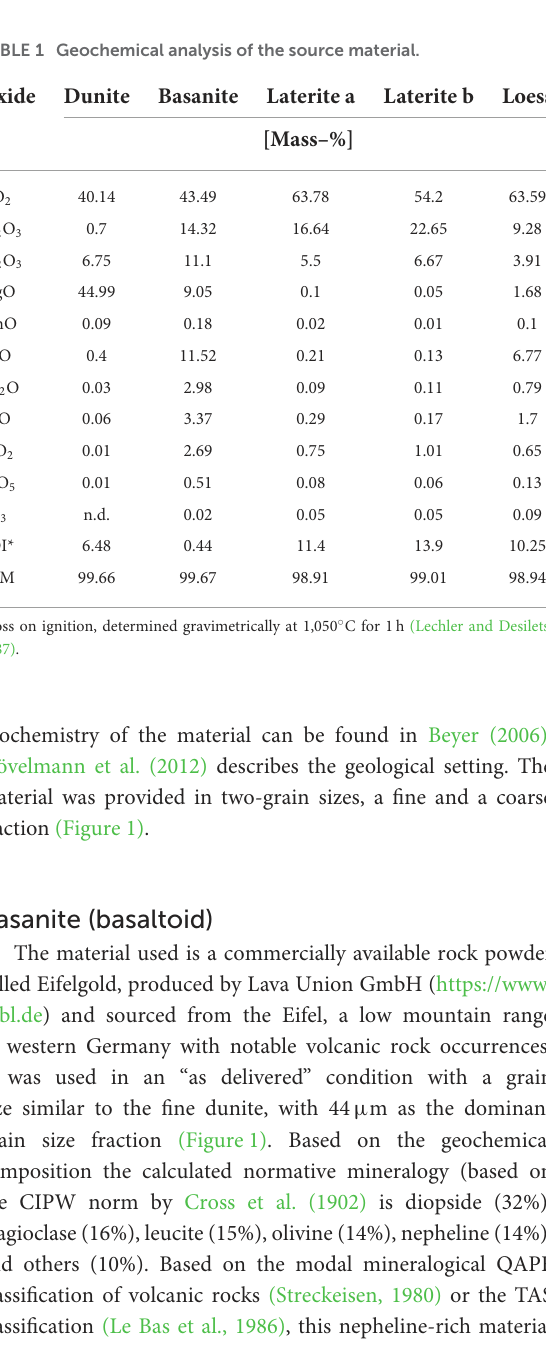
TABLE 1 Geochemical analysis of the source material.